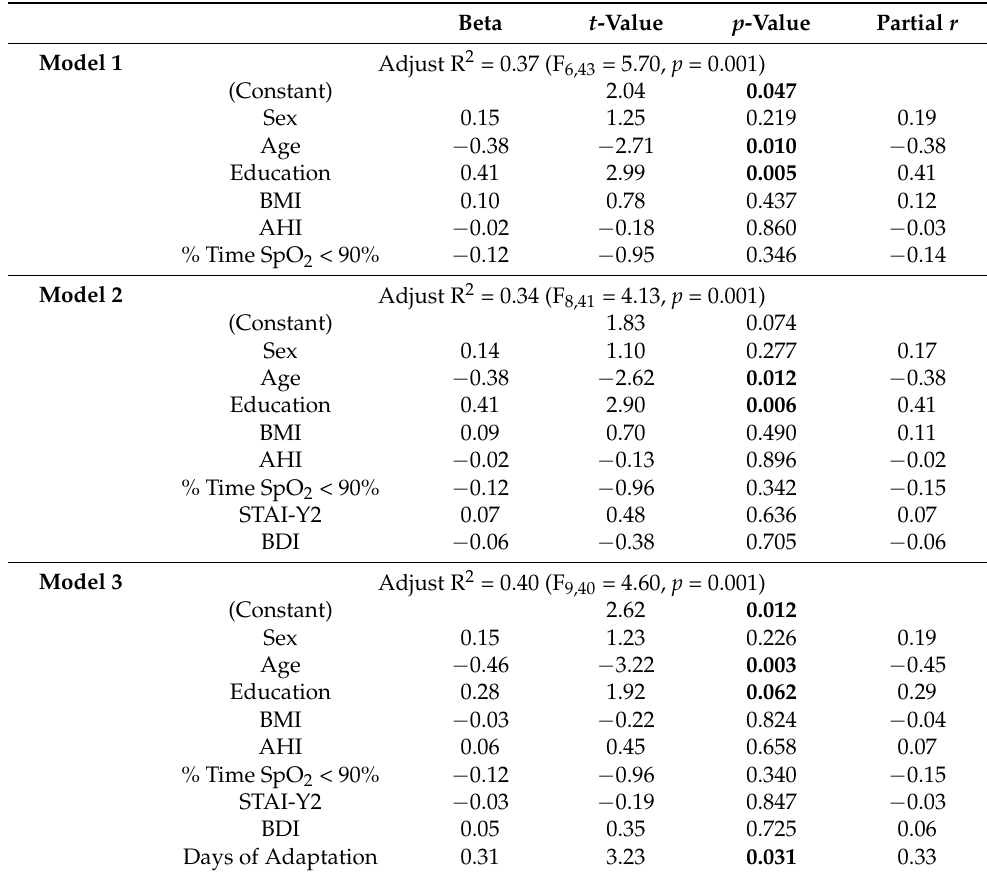
Table 5. Results of the hierarchical multiple linear regression analysis investigating the possible predictors of the delay recall ability (i.e., Selective Reminding Test—D score). Adjusted R 2 and F-statistics are reported for each model. Standardized Beta, t -values, p -values, and partial r correlation coefficients are reported for each predictor in each model. BMI: body mass index; AHI: apnea- hypopnea index; % Time SpO 2 < 90%: cumulative time spent with peripheral blood oxygen saturation (SpO 2 ) below 90%; STAI-Y2: State-Trait Anxiety Inventory form Y2; BDI: Beck Depression Inventory. Bold means significant results ( p ≤